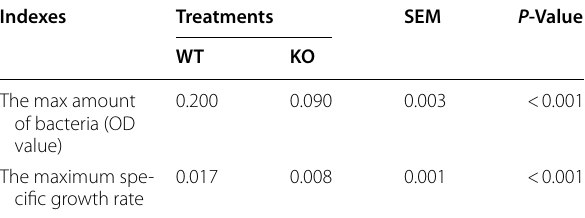
Table 2 Comparison in the methane production and growth indexes of wild-type and mutant M. ruminantium